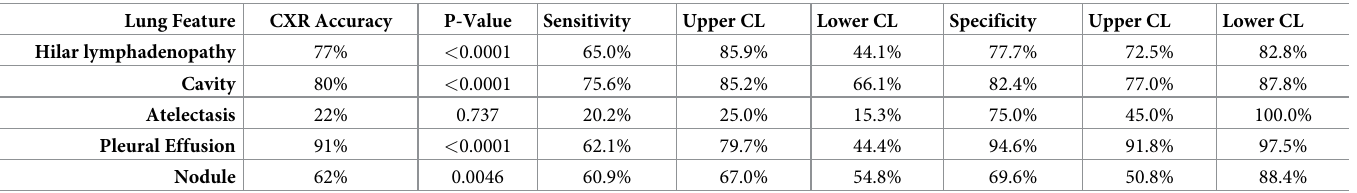
Table 4. 271 TBPP CXR Annotations for Drug Resistant TB versus Qure.ai Binary Prediction, Crosstabulation Summary Statistics. Lung